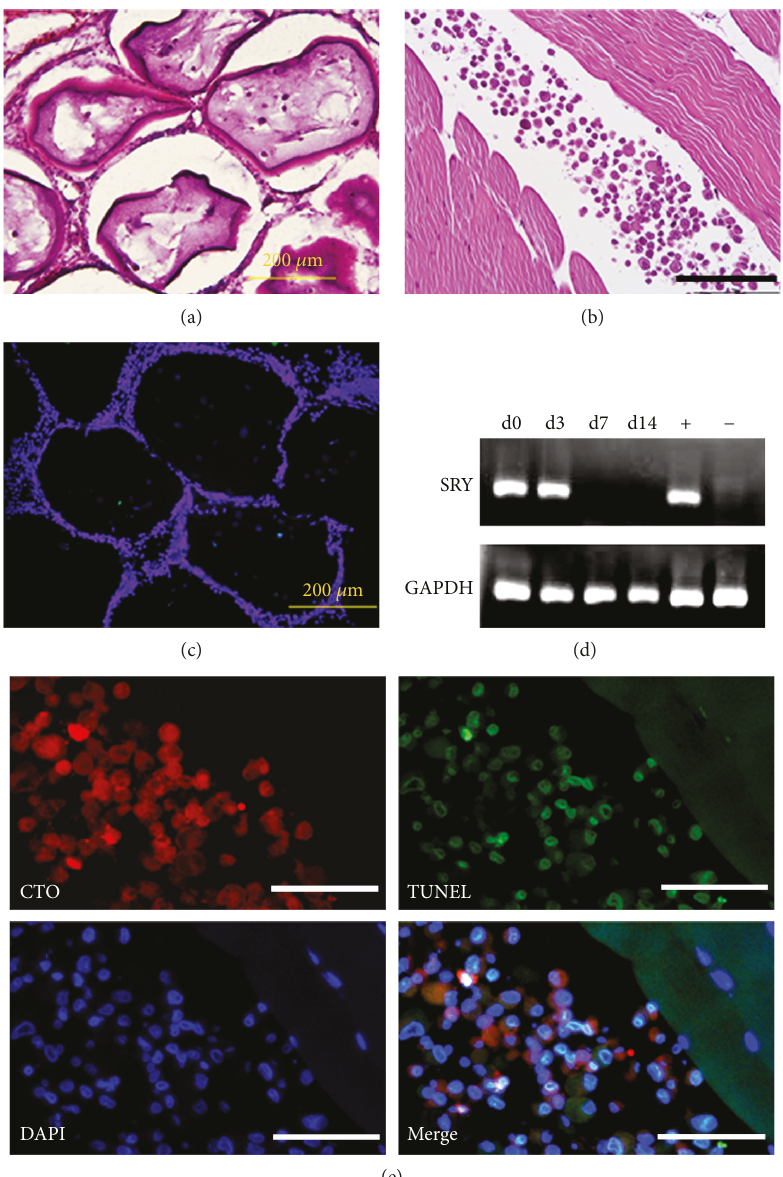
Figure 6: Histopathological analysis of MSC survival after transplantation. (a) Hematoxylin & eosin (H&E) staining of a rabbit receiving PFOBCaps with MSCsM shows absence of in fl ammatory cell in fi ltrate two weeks after delivery. (b) H&E staining of a rabbit receiving naked MSCs demonstrates no evidence of in fl ammatory in fi ltrates three days of postdelivery. (c) TUNEL staining reveals a few apoptotic MSCs (green, arrow) within PFOBCaps two weeks after transplantation. DAPI staining (blue) shows total cell nuclei. (d) qPCR analysis of Sry gene con fi rms the retention of male MSCs in rabbits up to three days of posttransplantation. Male rabbit MSCs serve as positive control (+) and female rabbit skeletal muscle cells serve as negative control (-). (e) TUNEL staining of CTO-labeled (orange) unencapsulated (or naked) MSCs reveals majority of cell death three days after delivery. Scale bars represent 200 μ m in (a – c) and 100 μ m in